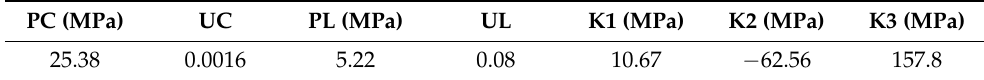
Figure 18. The fitting relationship between 𝑝 ∗ and 𝜇̅ . Table 7. The pressure parameters related to the material state.